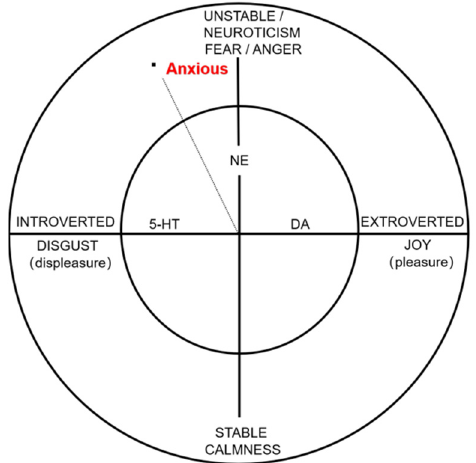
Figure 2. Personality trait–Emotion–Neurotransmitter diagrammatic figure. Extroverted–joy–dopamine (DA); introverted–disgust–5-hydroxytryptamine (5-HT); unstable (neuroticism)–anger / fear–noradrenaline (NE); stable–calmness. Anxiety traits are associated with both neuroticism and intro- version, and the ratio of correlations is approximately 2:1. Anxiety traits are associated with emo- tions such as fear (anger) and disgust and are regulated by 5-HT and NE [16,89,96].